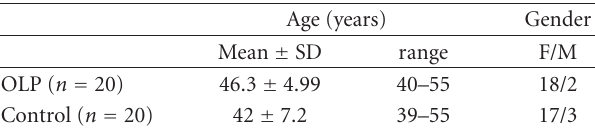
Table 1: The characteristics of